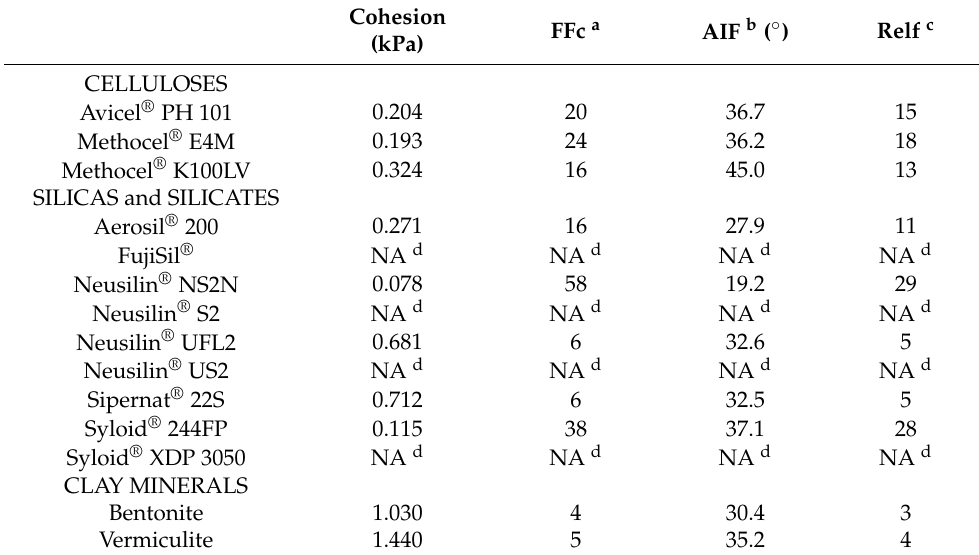
Table 8. Shear cell